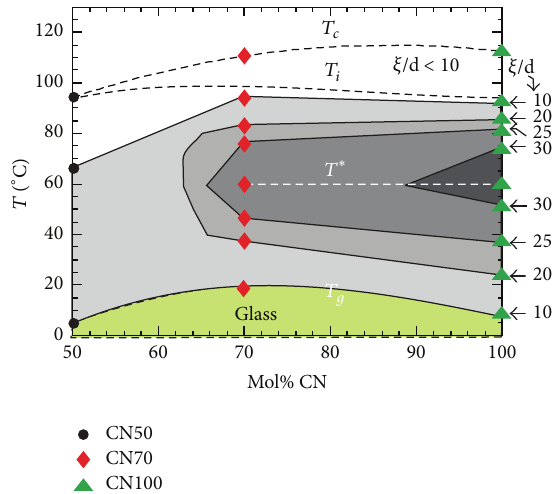
Figure 3: An overview of the nematic networks of ∙ CN50, X CN70, and 󳵳 CN100. The solid curves are lines of constant number of smectic layers correlated in a cluster, 𝜉/𝑑 (shown to the right of the figure), with 𝜉 , the layer correlation length, and 𝑑 , the layer spacing (Figure 2), measured by synchrotron radiation. 𝜉/𝑑 is maximum ( ∼ 28.3 layers for CN70, and 31.5 layers for CN100) on the dashed line 𝑇 ∗ = 60 ∘ C between CN70 and CN100 compared to about 10 layers at 𝑇 𝑖 where smectic clusters first appear. 𝑇 𝑐 is the cross-linking temperature. 𝑇 𝑔 is the glass transition temperature. The maximum number of correlated layers in CN50 is 12 at ∼ 40 ∘ C and is only about 2 at 𝑇 𝑖 and 10 at 𝑇 𝑔 . The dashed curve for 𝑇 𝑖 is deduced from measurements of spontaneous shape change, 𝜆(𝑇) , measured in the optical microscope, discussed in Section 2.3. 𝑇 𝑔 is estimated from the 𝜆(𝑇) ’s in Figure